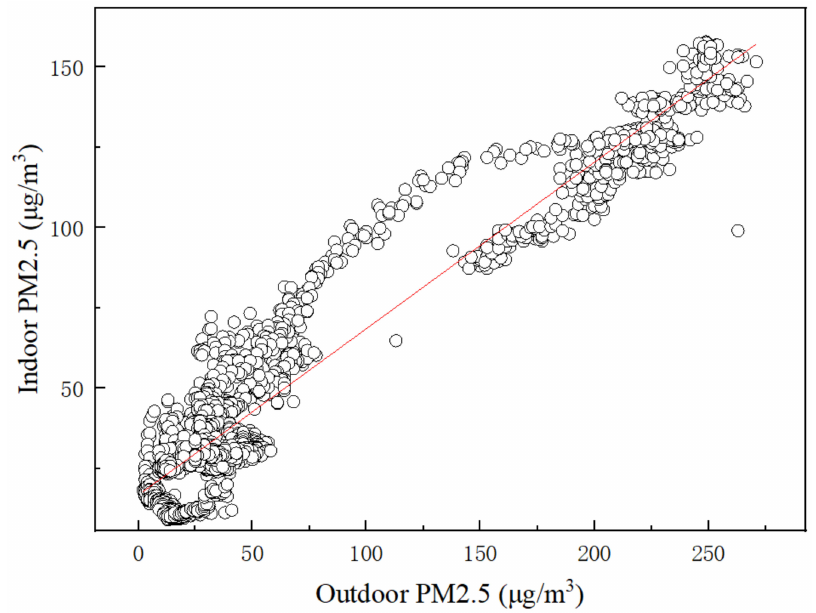
Figure 12. Correlation between indoor PM 2.5 and outdoor PM 2.5